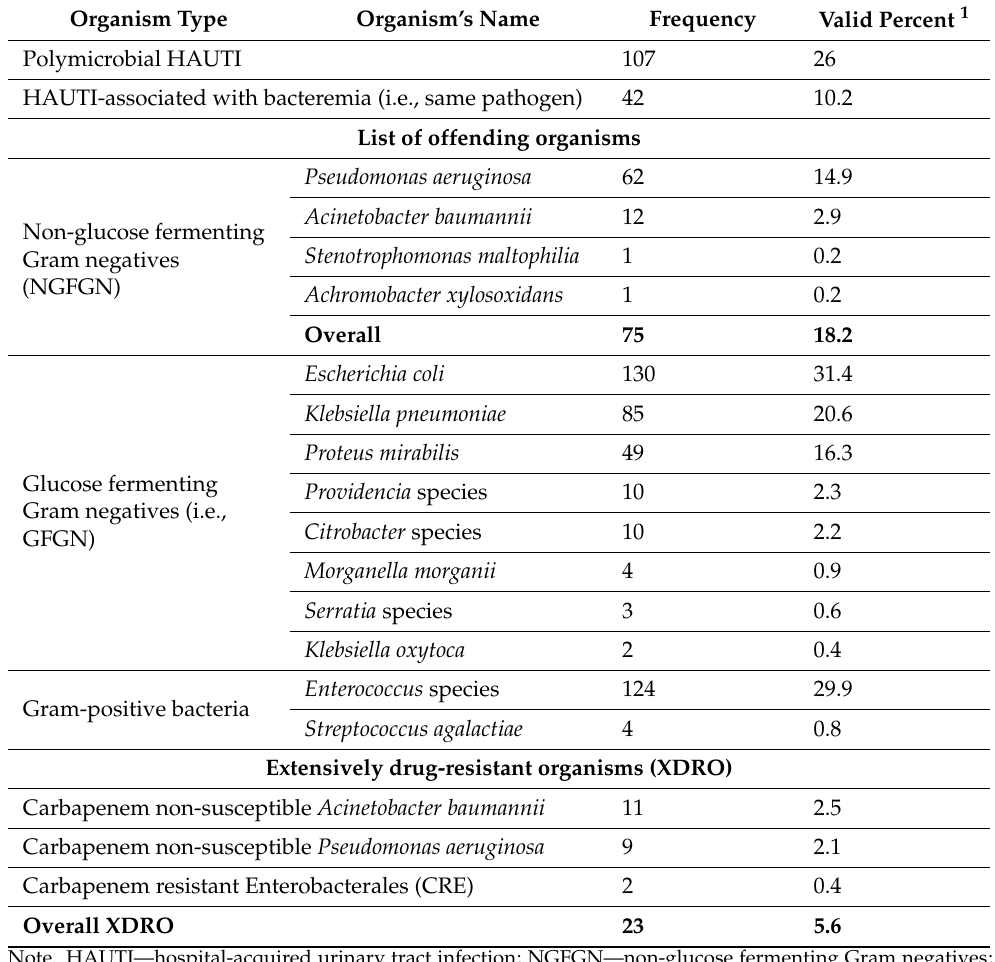
Table 1. Pathogens of hospital-acquired urinary tract infections (HAUTI), Shamir Medical Center,